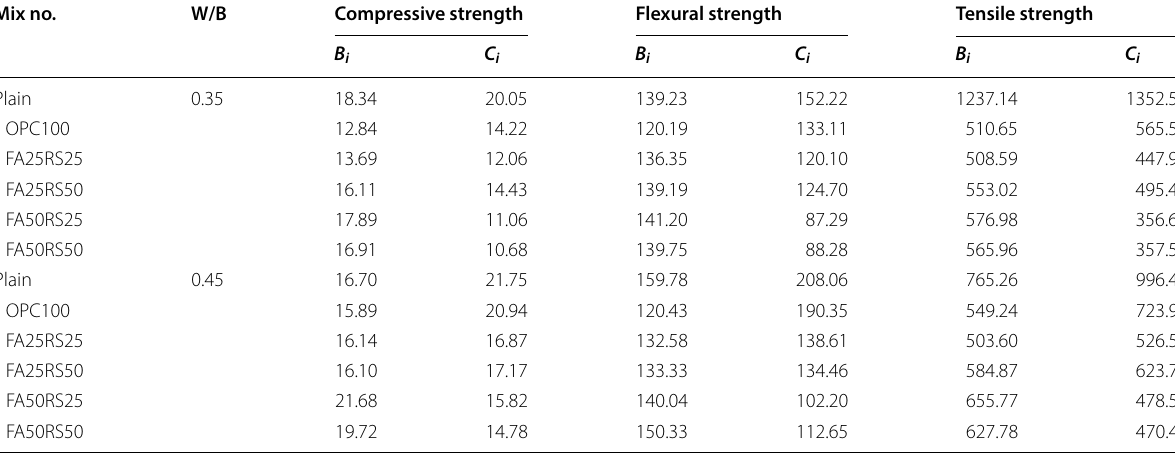
Table 8 B i and C i of compressive, flexural and tensile strengths. Mix